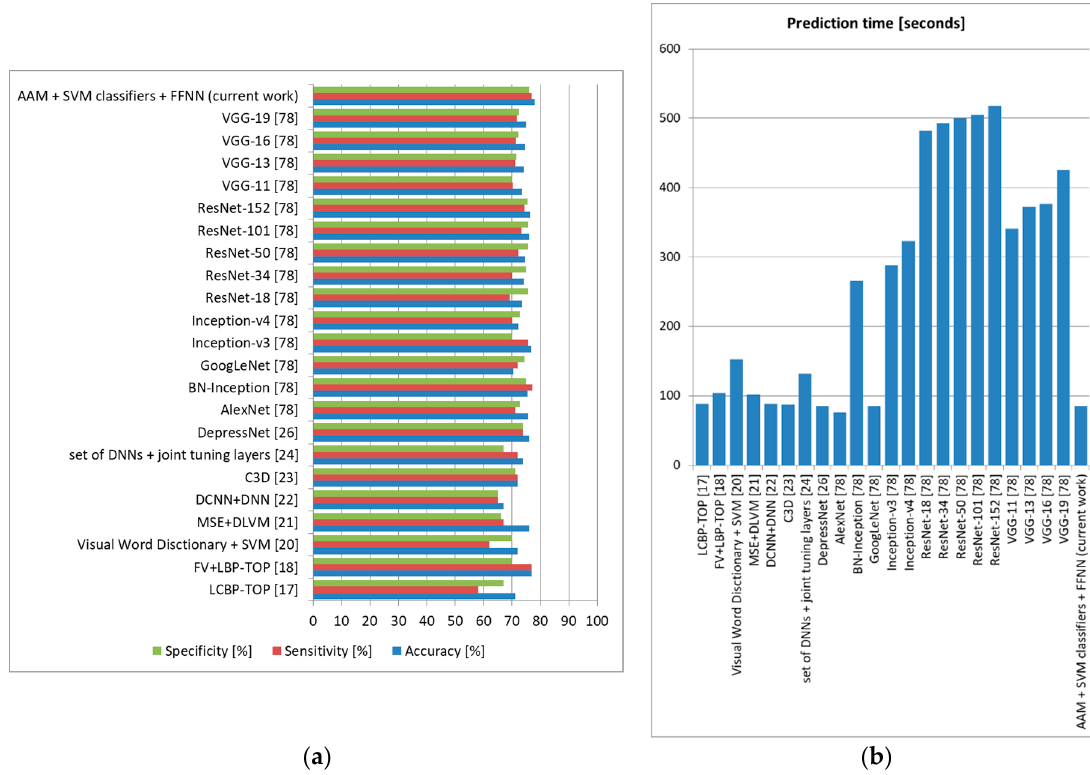
Figure 18. Depression prediction comparison to state-of-the-art methods (AVEC2014 [19]). ( a ) Average accuracy, sensitivity, and specificity, ( b ) Average prediction time (seconds).